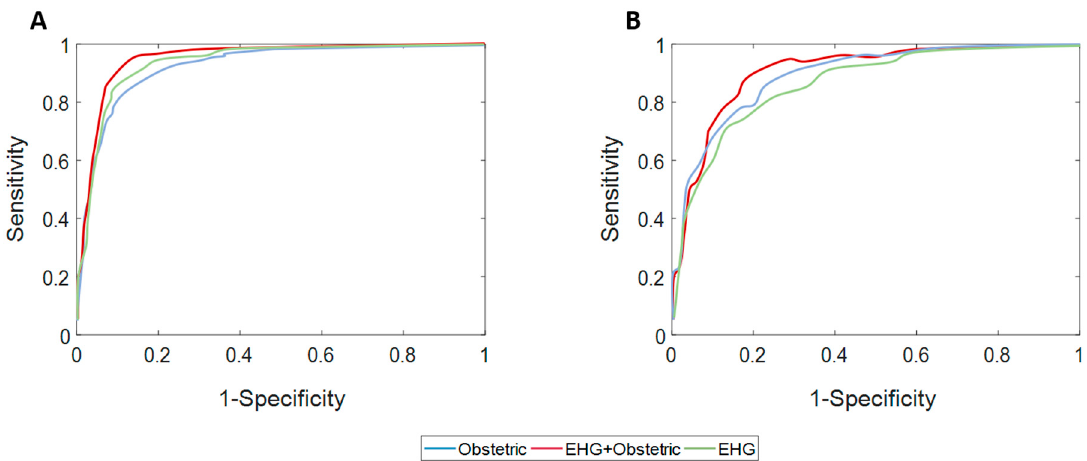
Figure 3. Average ROC curves for testing data when using different input features to predict labor in <7 days ( A ) and <14 days ( B ).